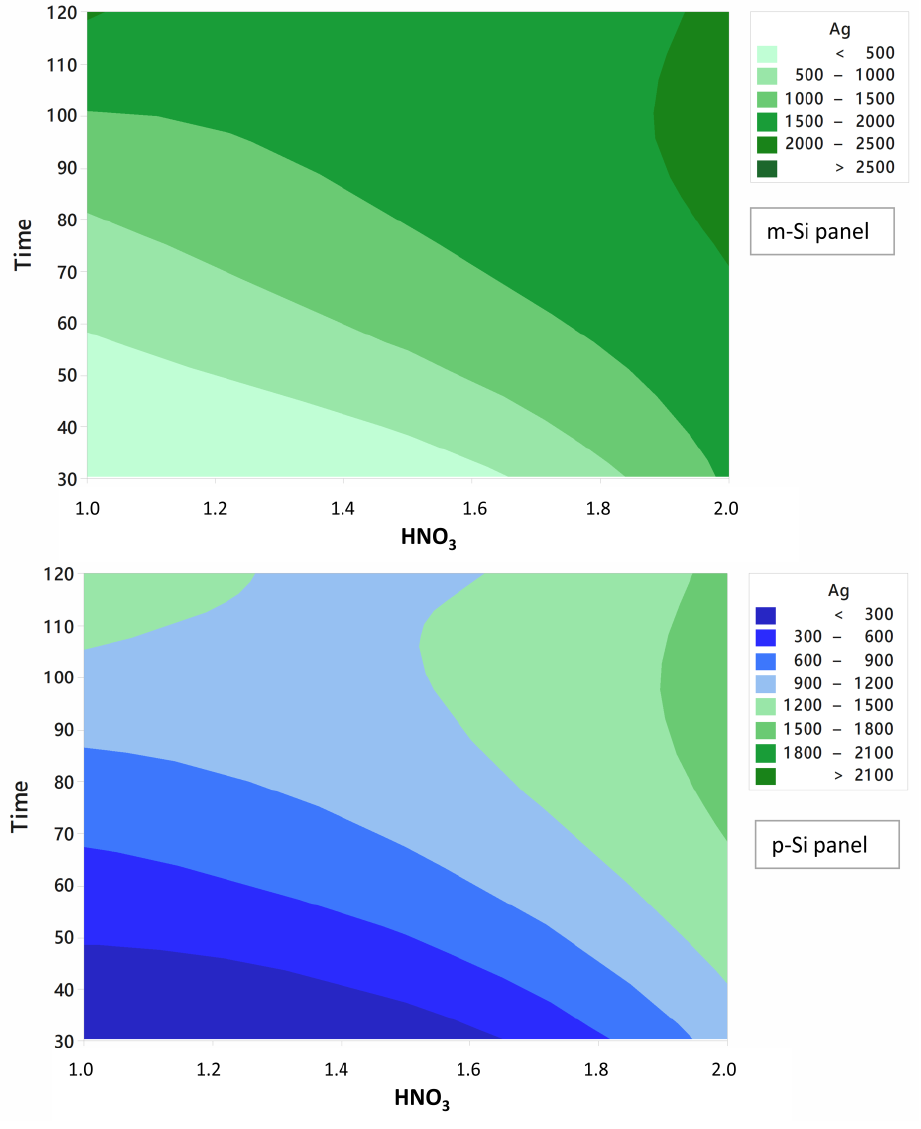
Figure 4. Fitted contour plots of Ag concentration vs. time and HNO 3 concentration for m-Si and p-Si panels.